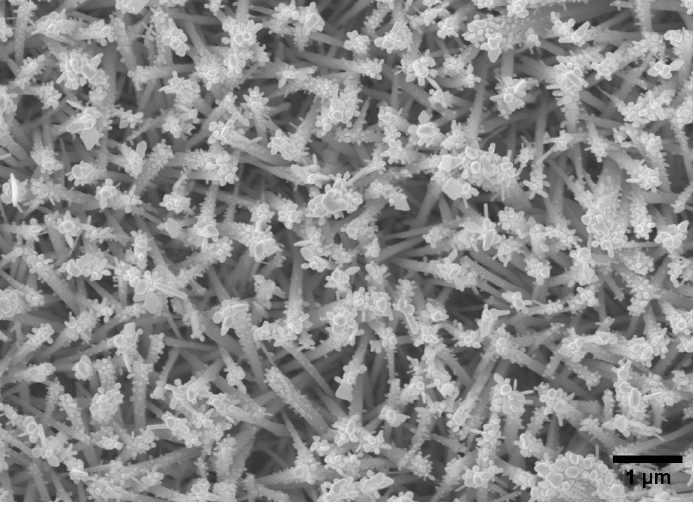
Figure 7. SEM image of Au/WO 3 film deposited via CVD (top view). Table 1. Summary of the ALD Al 2 O 3 thin film deposition parameters and the film thickness on Au/WO 3 , FTO and silicon.